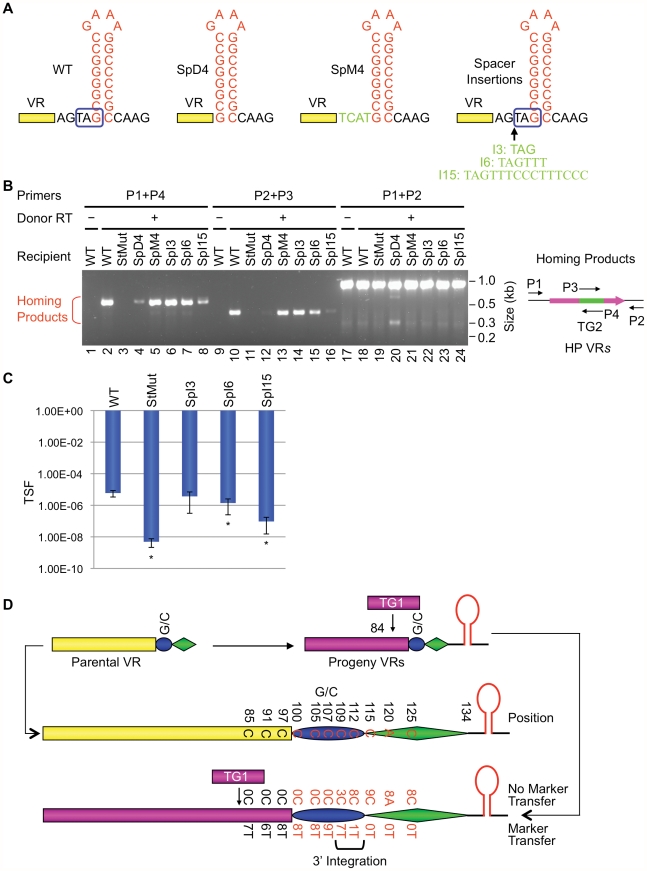
The VR-hairpin/cruciform spacer affects target recognition efficiency but not 3′ cDNA integration site.(A) Modifications introduced in the spacer between VR and the hairpin/cruciform structure. SpD4, the 4 bp spacer was deleted; SpM4, residues of the 4 bp spacer were switched to their complementary nucleotides; SpI3, SpI6 and SpI15 are spacer insertion mutants that retain the mtd stop codon for proper Mtd production. Boxed TAG, mtd stop codon. (B) Effects of spacer modifications on DGR mutagenic homing. PCR-homing assays are shown along with primers used. (C) Effects of spacer modifications on phage tropism switching. The bars represent mean TSF ± s.d. P values comparing mutants to WT in Student's t test are indicated with asterisks. *P<0.05. Tropism switching data are not available for constructs SpD4 and SpM4, as both modifications eliminate the mtd stop codon and do not produce functional phage particles. (D) Summary of marker coconversion analysis with BPP-1ΔATRSpI6. BPP-1ΔATRSpI6 phage particles were used for single-cycle lytic infection of RB50 cells transformed with marked donor plasmids. Progeny phage DNAs were used for PCR-based DGR homing assays. PCR products were cloned and sequenced and marker coconversion data are summarized. Nucleotide residues in the parental VR that correspond to the marked positions in TR are shown in the center. Numbers of progeny VRs with or without transferred markers at designated sites are shown at the bottom. The deduced cDNA integration region at the 3′ end of VR is indicated by a bracket.